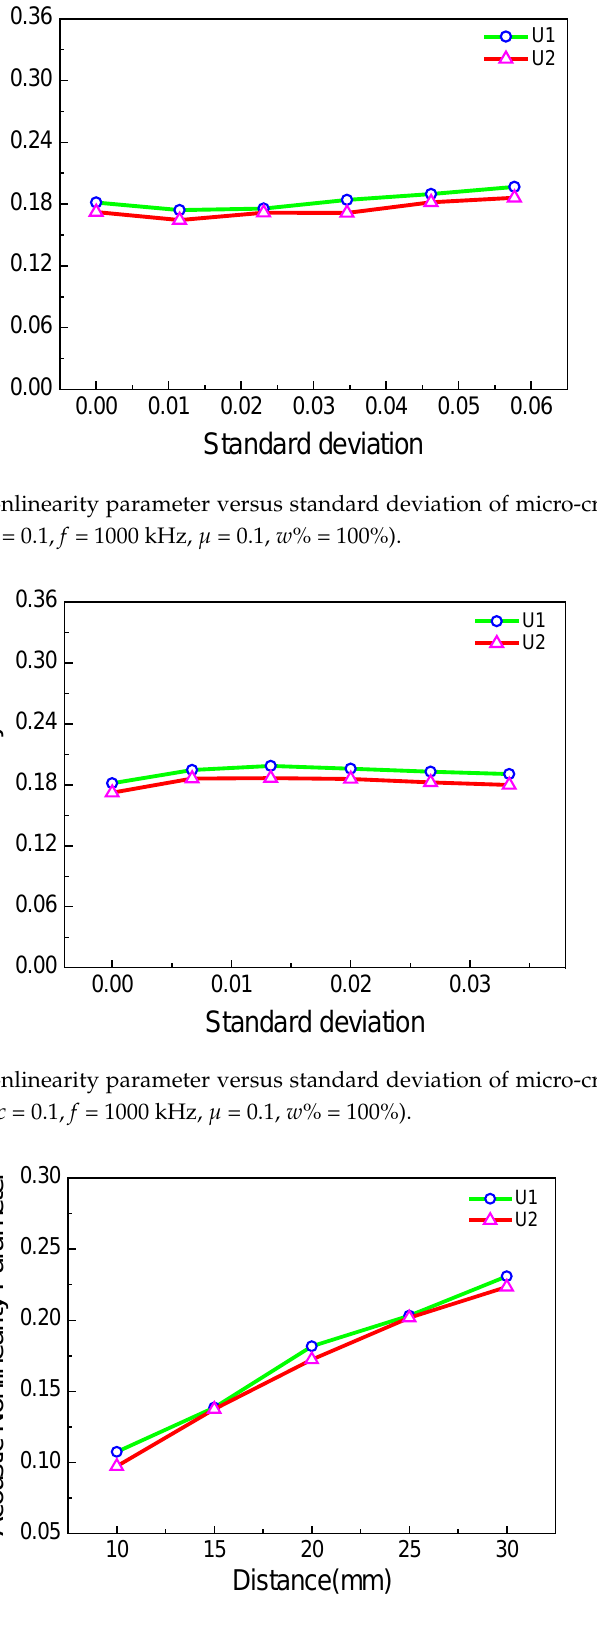
Figure 12. Acoustic nonlinearity parameter versus the propagation distance in the micro-crack zone ( c = 0.1, f = 1000 kHz, µ = 0.1, % = 100%). 𝑤𝑤